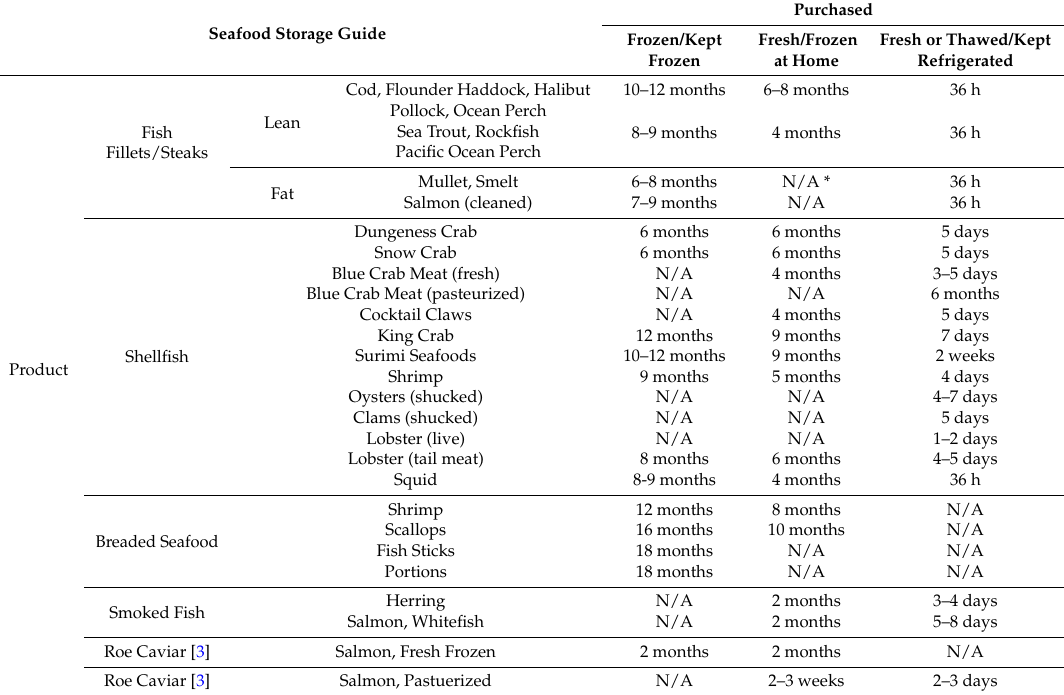
Table 1. Seafood Storage Guide